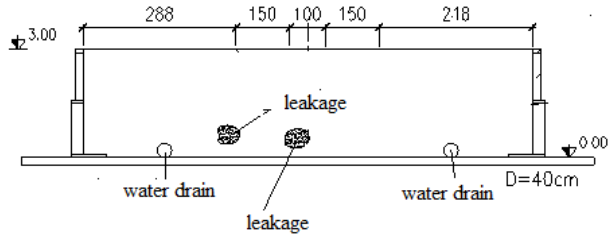
Figure 8: Cross sectional area of the dam with intentionally generated leakages